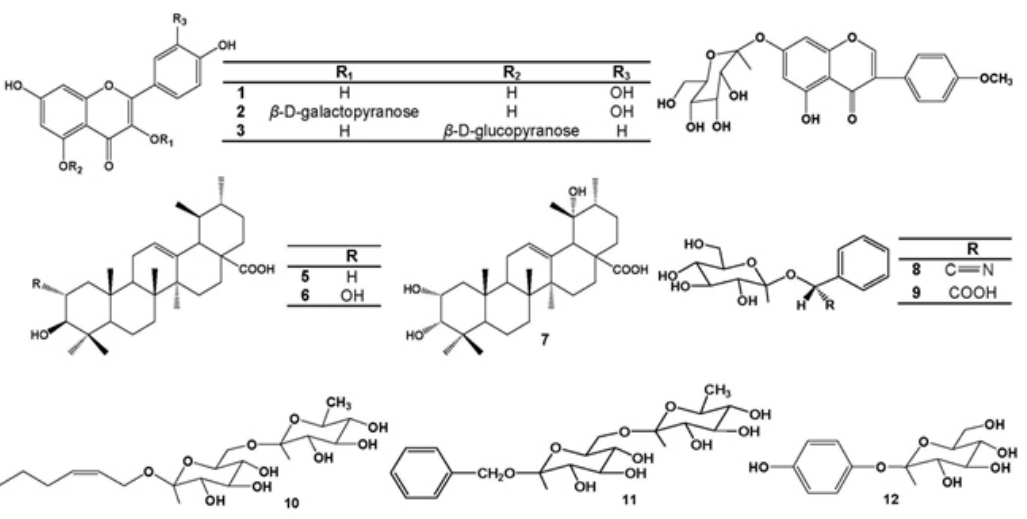
Fig. 1. Compounds 1 - 12 isolated from leaves of C.mongolica Pojark.